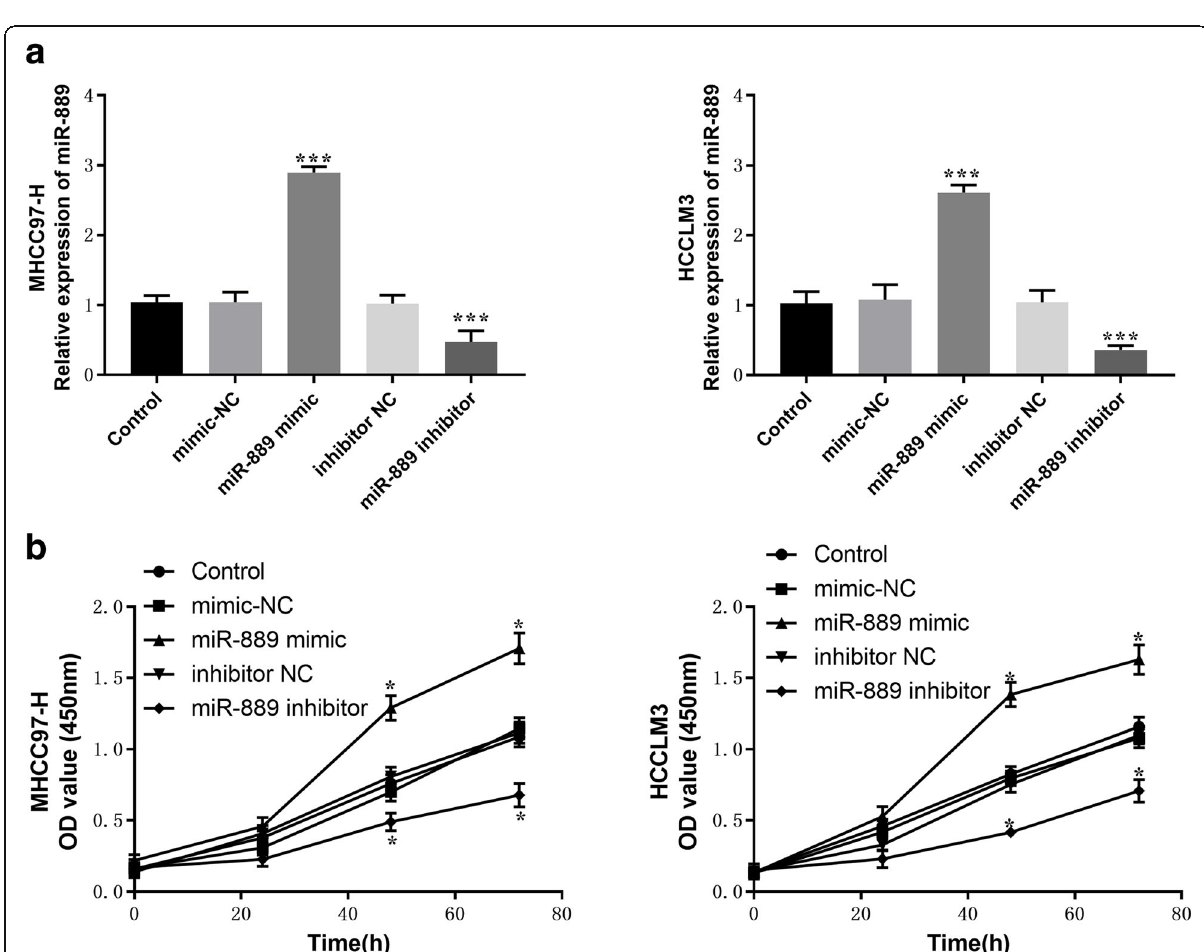
Fig. 3 Effects of miR-889 expression levels on proliferation in MHCC97-H and HCCLM3 cells. a the expression level of miR-889 was verified by qRT-PCR after transient transfection with miR-889 mimic/inhibitor (or mimic/inhibitor NC). b The CCK-8 assay was performed to examine cell proliferation. * P < 0.05, *** P <